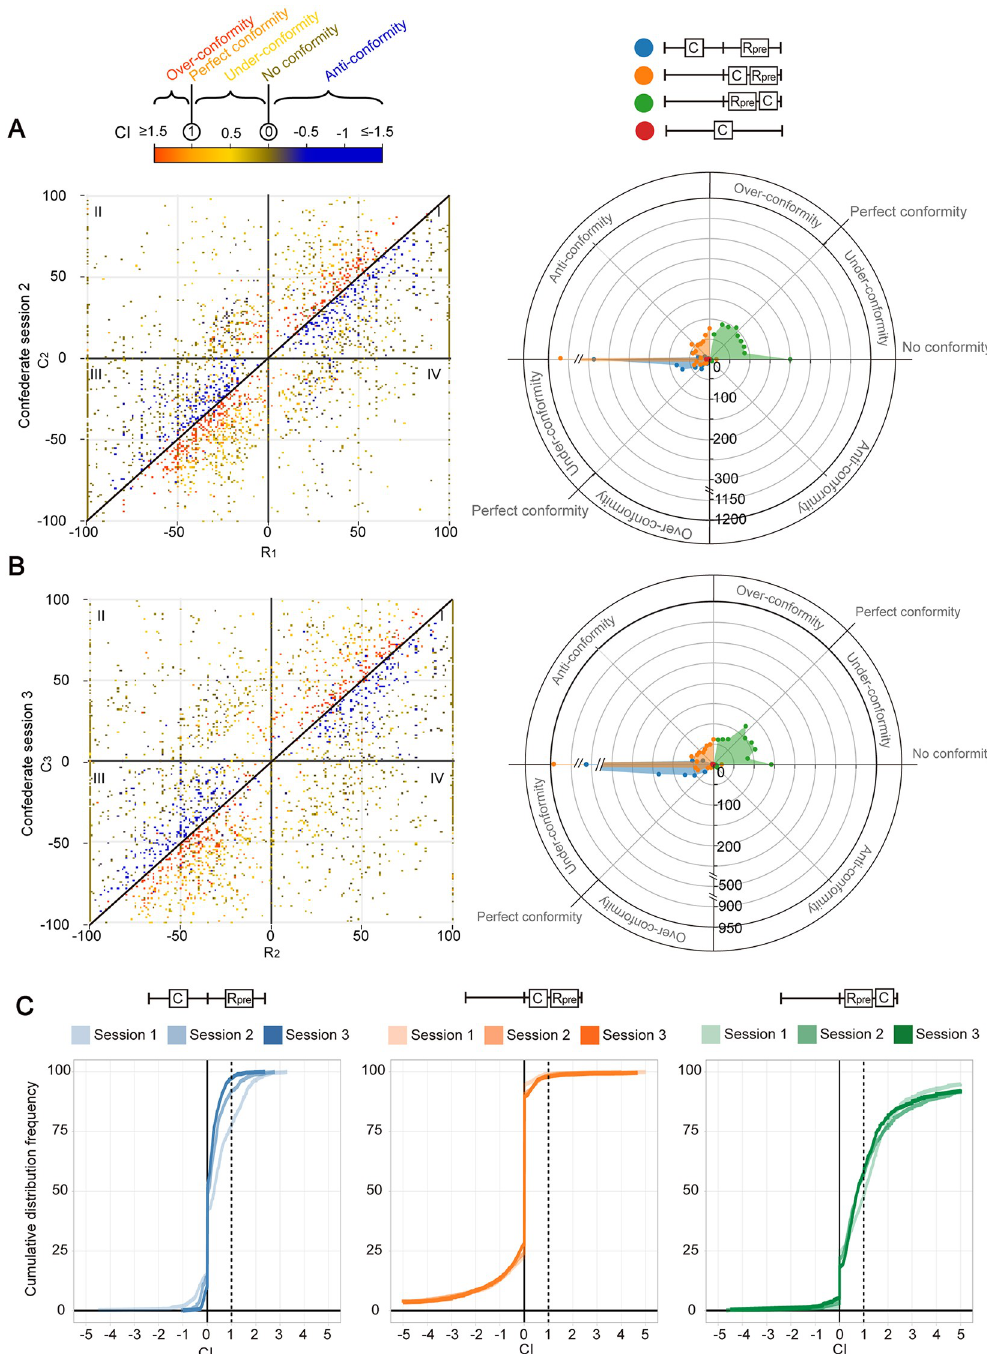
Fig 4. Level of conformity to the second and third confederate’s answers. (A and B) Same as Fig 3A and 3C but for session 2 (panel A, n = 3377) and session 3 (panel B, 3376). (C) Cumulative distribution frequency plots showing the distribution of CI in the three sessions. CI calculated and colours indicated as in Fig 4A and 4B (Right). Dotted lines are plots CI = 1. Data points with invalid CI were excluded. Left: n = 521, 647, 899 for session 1, 2, 3; Middle: n = 1665, 1731, 1497 for session 1, 2, 3; Right: n = 1079, 940, 916 for session 1, 2, 3.